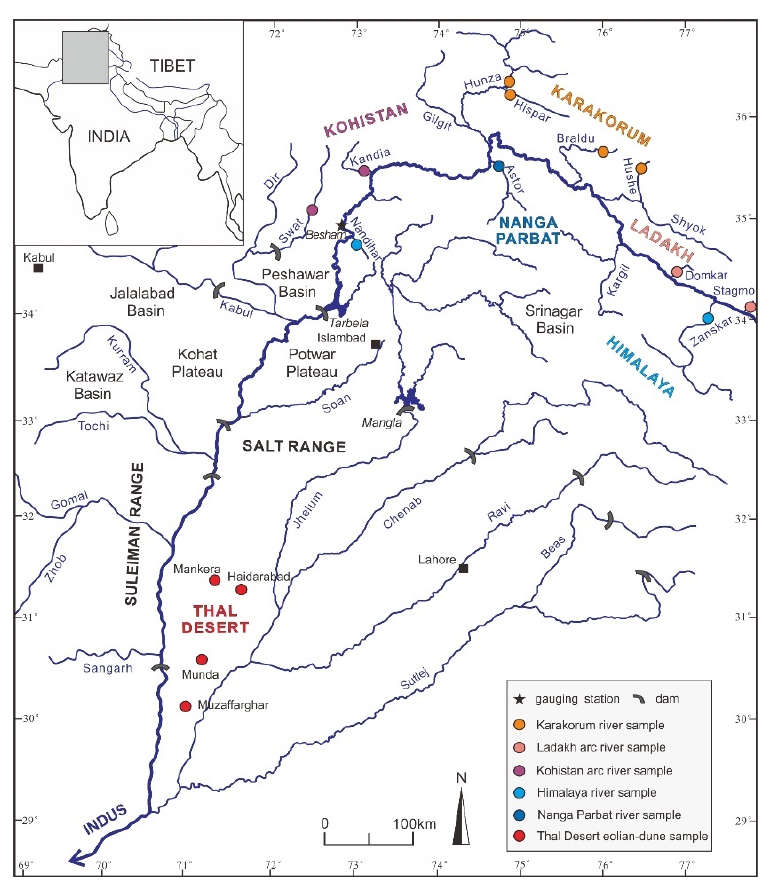
Figure 1. The Indus drainage system and sample locations in northern Pakistan.